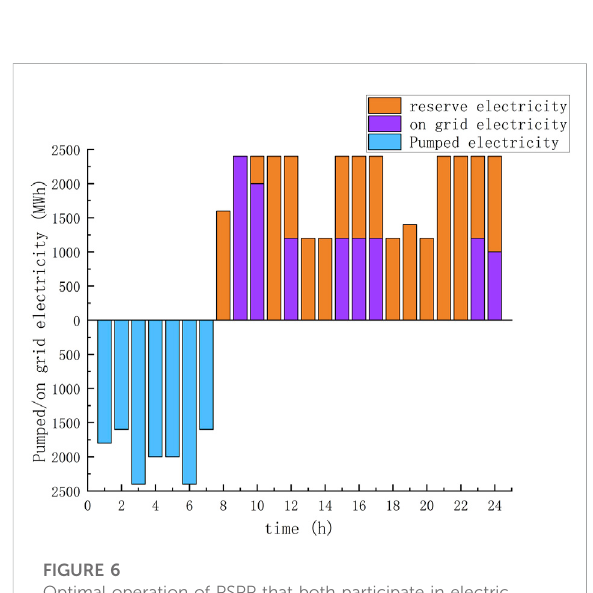
FIGURE 6 Optimal operation of PSPP that both participate in electric energy and ancillary services spot market in scenario 7.